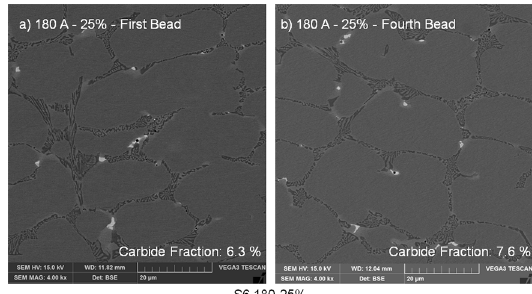
Figure 7. Typical coatings microstructure: 180 A, 25 % overlapping.